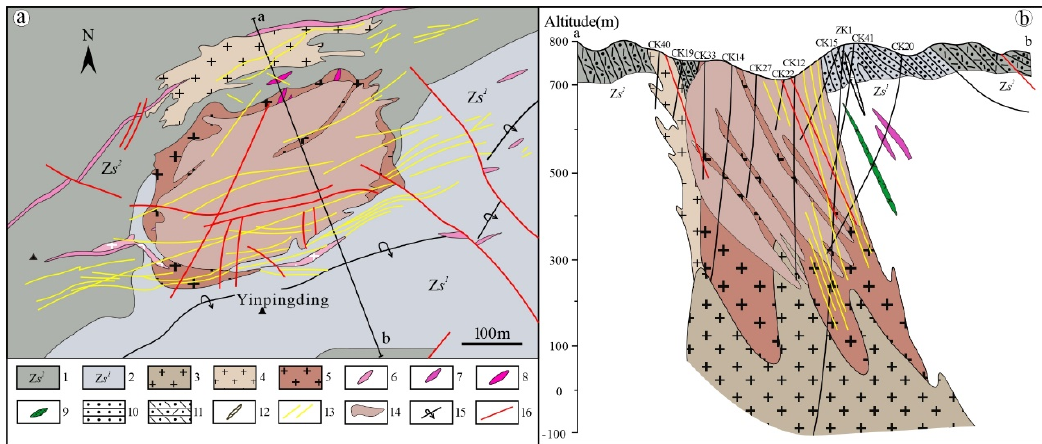
Figure 3. ( a ) Geological map of the Xingluokeng W-Mo polymetallic deposit (modified after [2]). ( b ) A NNW-SSE trending cross-section of the Xingluokeng W-Mo polymetallic deposit (modified after [33]). 1 = the second section of Sanxizhai Formation; 2 = the first section of Sanxizhai Formation; 3 = early Yanshanian fine-grained porphyritic granite; 4 = early Yanshanian fine- to medium-grained granite; 5 = early Yanshanian porphyritic biotite granite; 6 = granite-porphyry dyke; 7 = aplite dyke; 8 = borengite dyke; 9 = sillite dyke; 10 = hornfelsic metamorphic siltstone; 11 = hornfelsic tuff; 12 =